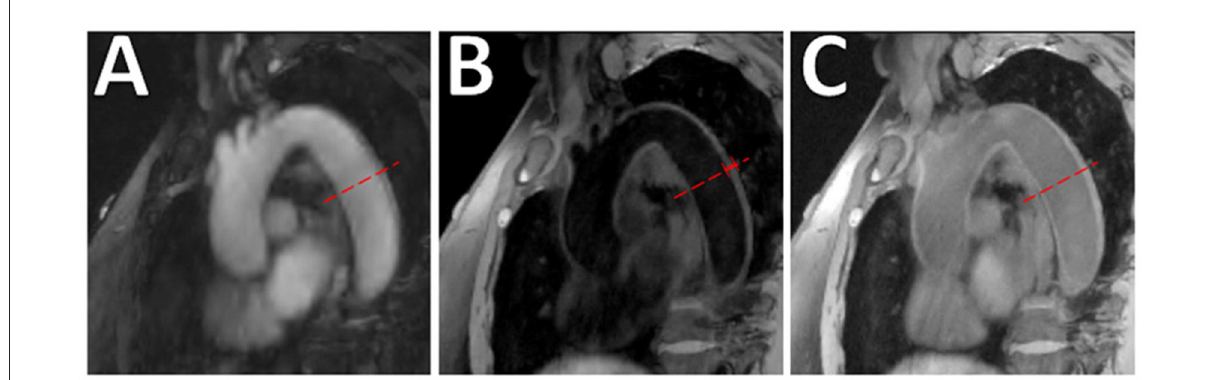
FIGURE10 Aortic VW-MRI using the MR MultiTasking based 3D Multidimensional Assessment of Cardiovascular System (MT-MACS) Technique. (A) In a 71-year-old patient with aortic atherosclerosis, bright-blood lumenography, (B) dark-blood (vessel wall imaging), and (C) gray-blood (optimized to detect calcium/calcified nodules) images were acquired. In the thoracic aorta (dashed line), increased aortic wall thickness (4.491mm) was measured and most conspicuous on the dark-blood (B) and gray-blood (C) images. [These images are re-printed with permission from Zhaoyang Fan, PhD from Magnetic Resonance in Medicine